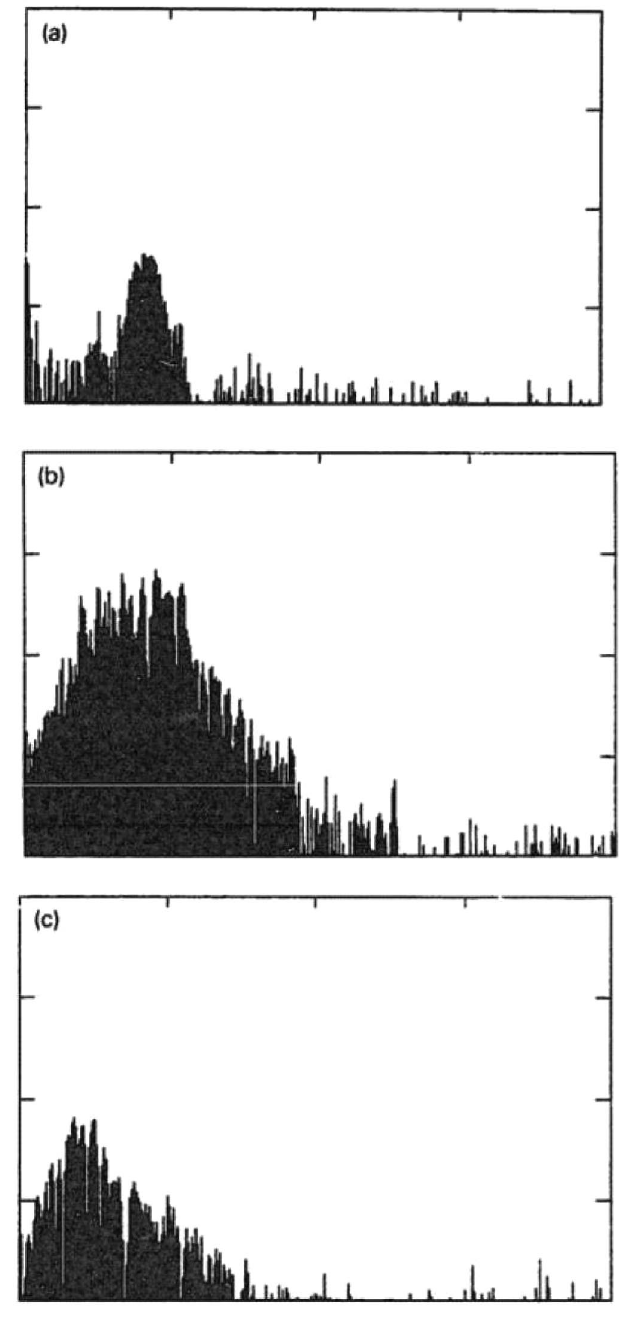
FIG. 8. Spectra recorded during a single PSR cycle with a strong instability [23]; (a) shows the spectrum at the beginning of the instability, (b) 100 (cid:7) s later, and (c) 300 (cid:7) s later after beam loss; the vertical scale is logarithmic; the horizontal span extends from 0 to 1 GHz.